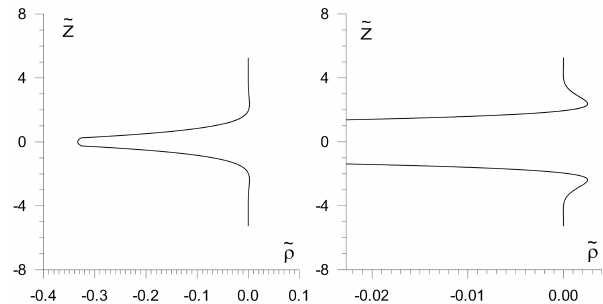
Figure 2. Modeled vertical profile of density disturbances Re( d F/ d z) = Reρ = e ρ for case 2. The function Re( d F 3 / d z) (left) and its stretched fragment (right) versus the dimensionless co- ordinate e z = z · (ks/K) 1 / 4 are presented for k = 10 − 5 m − 1 , s = 10 − 7 m − 1 s − 1 , and K = 10 − 5 m 2 s − 1 .